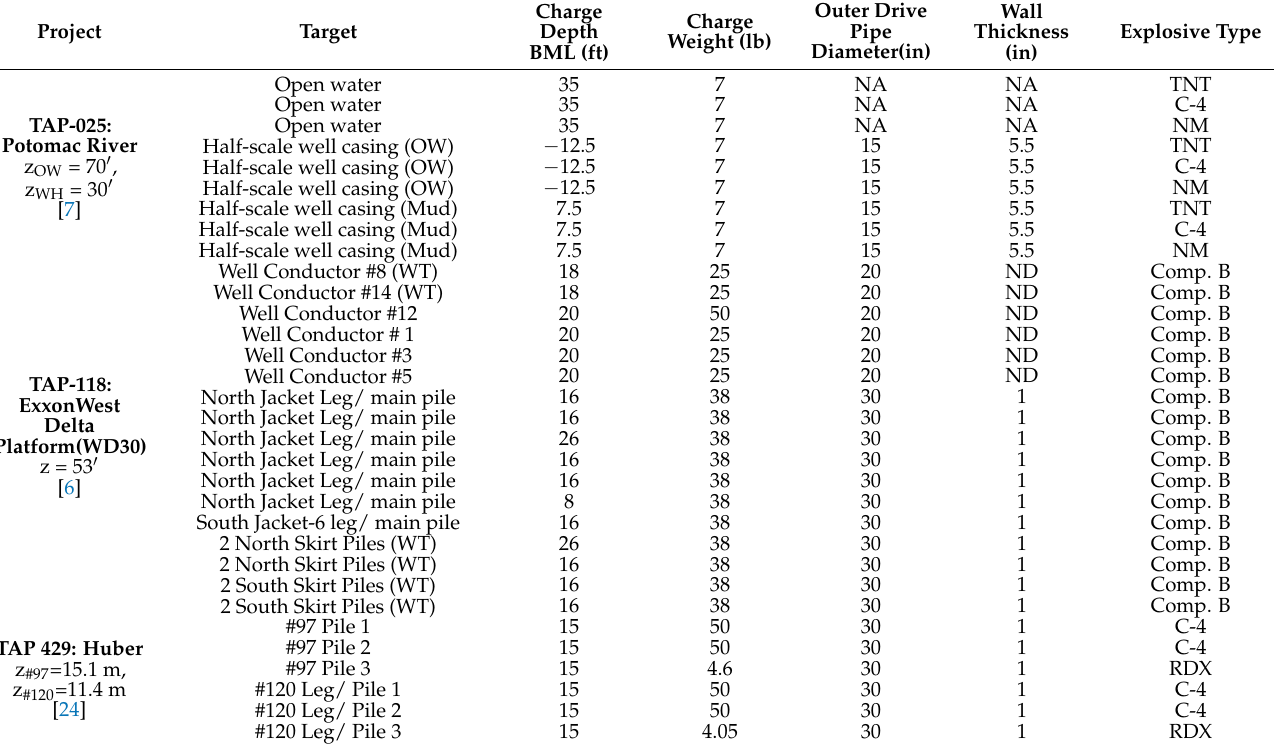
Table A1. Previous explosive-severance studies conducted by the US Department of the Interior’s Minerals Management Service (MMS, now BOEM and BSEE). Notes: Technology Assessment Program (TAP) Projects were previously known as Technology Assessment Research (TAR) Projects before the creation of the Bureau of Safety and Environmental Enforcement (BSEE). Units are as given in original